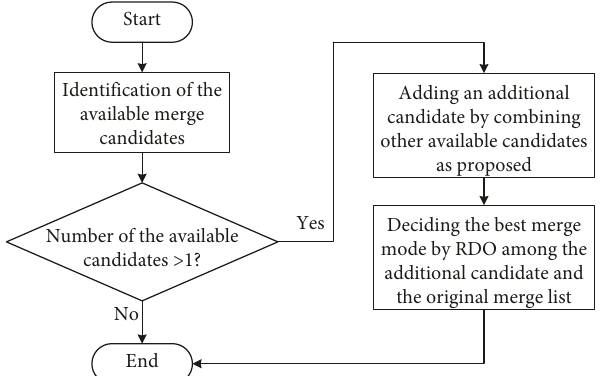
Figure 4: Schematic diagram of the proposed merge candidate for the merge